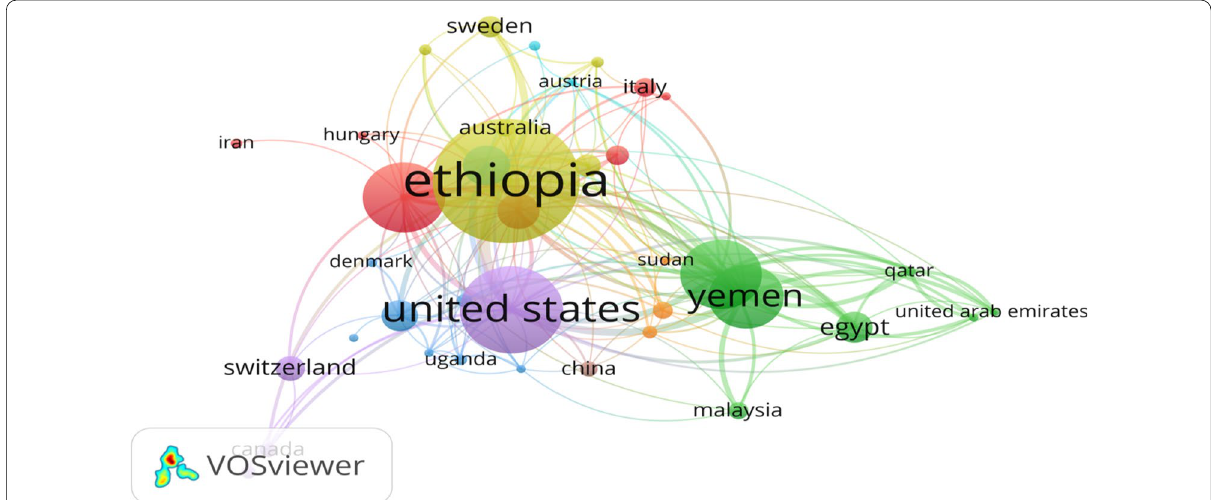
Fig. 10 Countries with five documents as a minimum number. Total link strength describes the strength of co-authorship